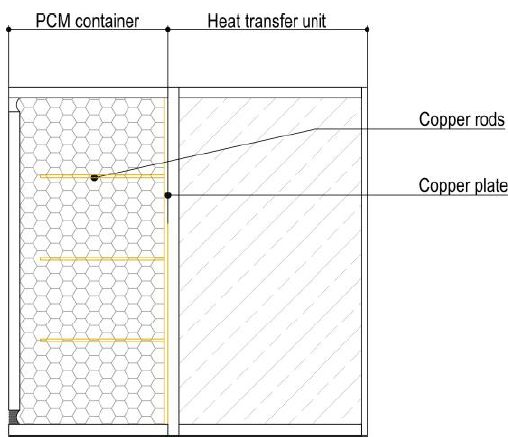
Fig. 1. Passive solar module: schematic